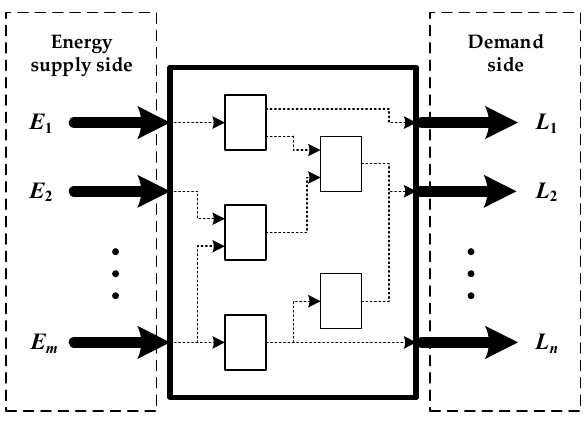
Figure 2. Integrated energy system schematic.